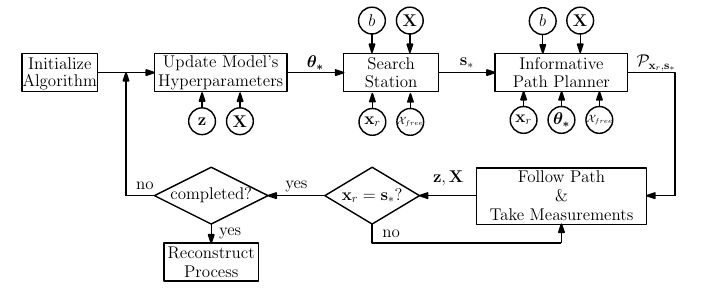
, b , StopAlgorithm X free